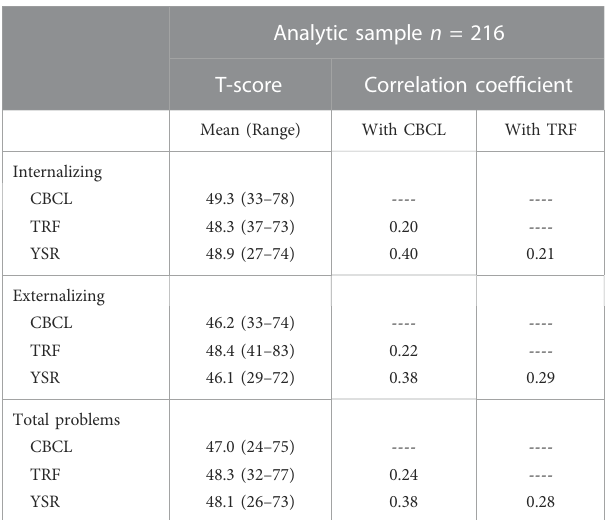
TABLE2MeanT-Scoresandpearsoncorrelation coef fi cientsforCBCL,TRF,and YSR assessments collected during adolescents only.